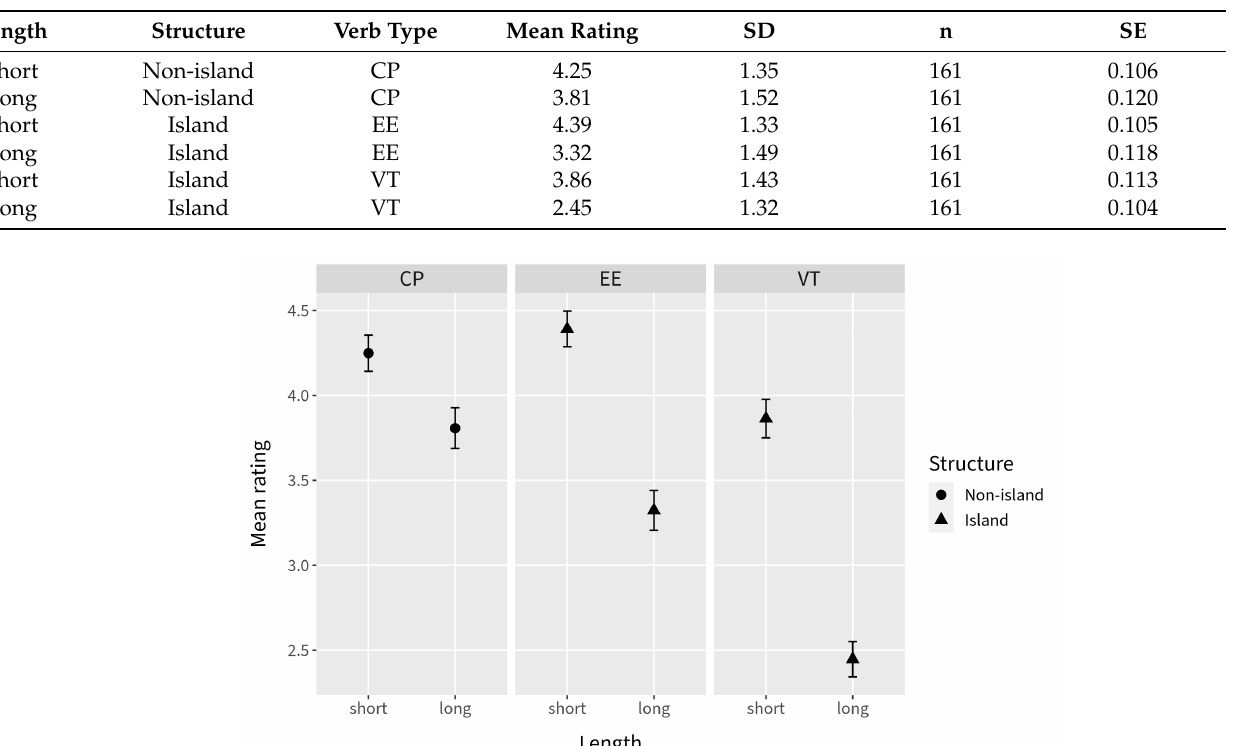
Table 4. Descriptive statistics for Experiment 2 results. Mean is calculated on raw (non-z-scored) ratings.